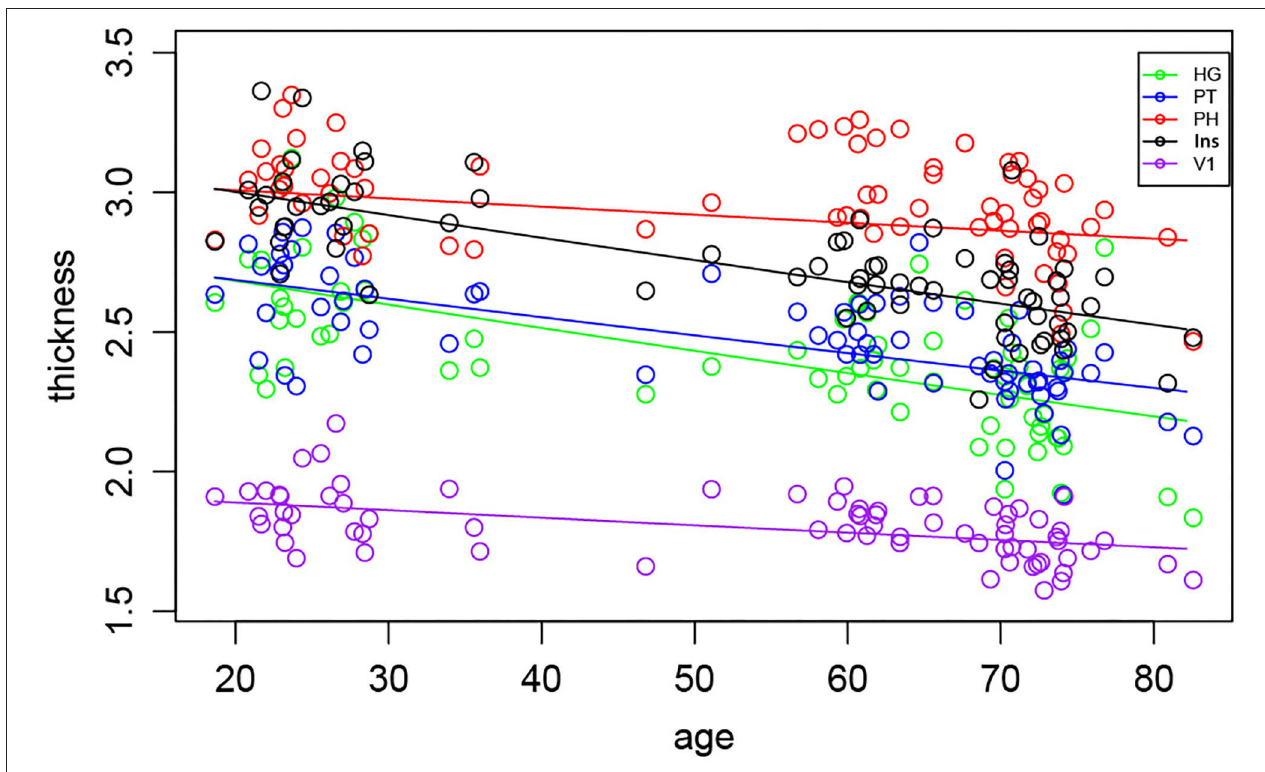
FIGURE 3 | Morphometric analysis of the cortical thickness in all examined regions with the exception of the Amg and HP, shows age-related decrease. Each symbol represents one